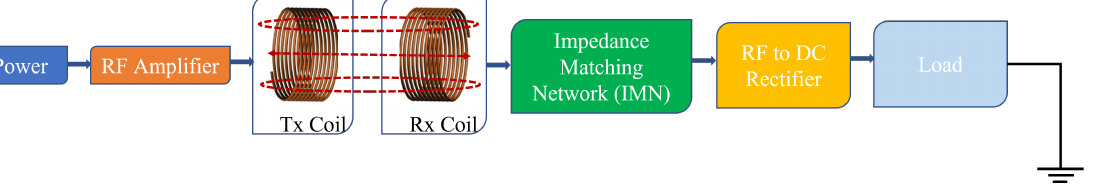
Figure 6. Inductive coupling for WPT